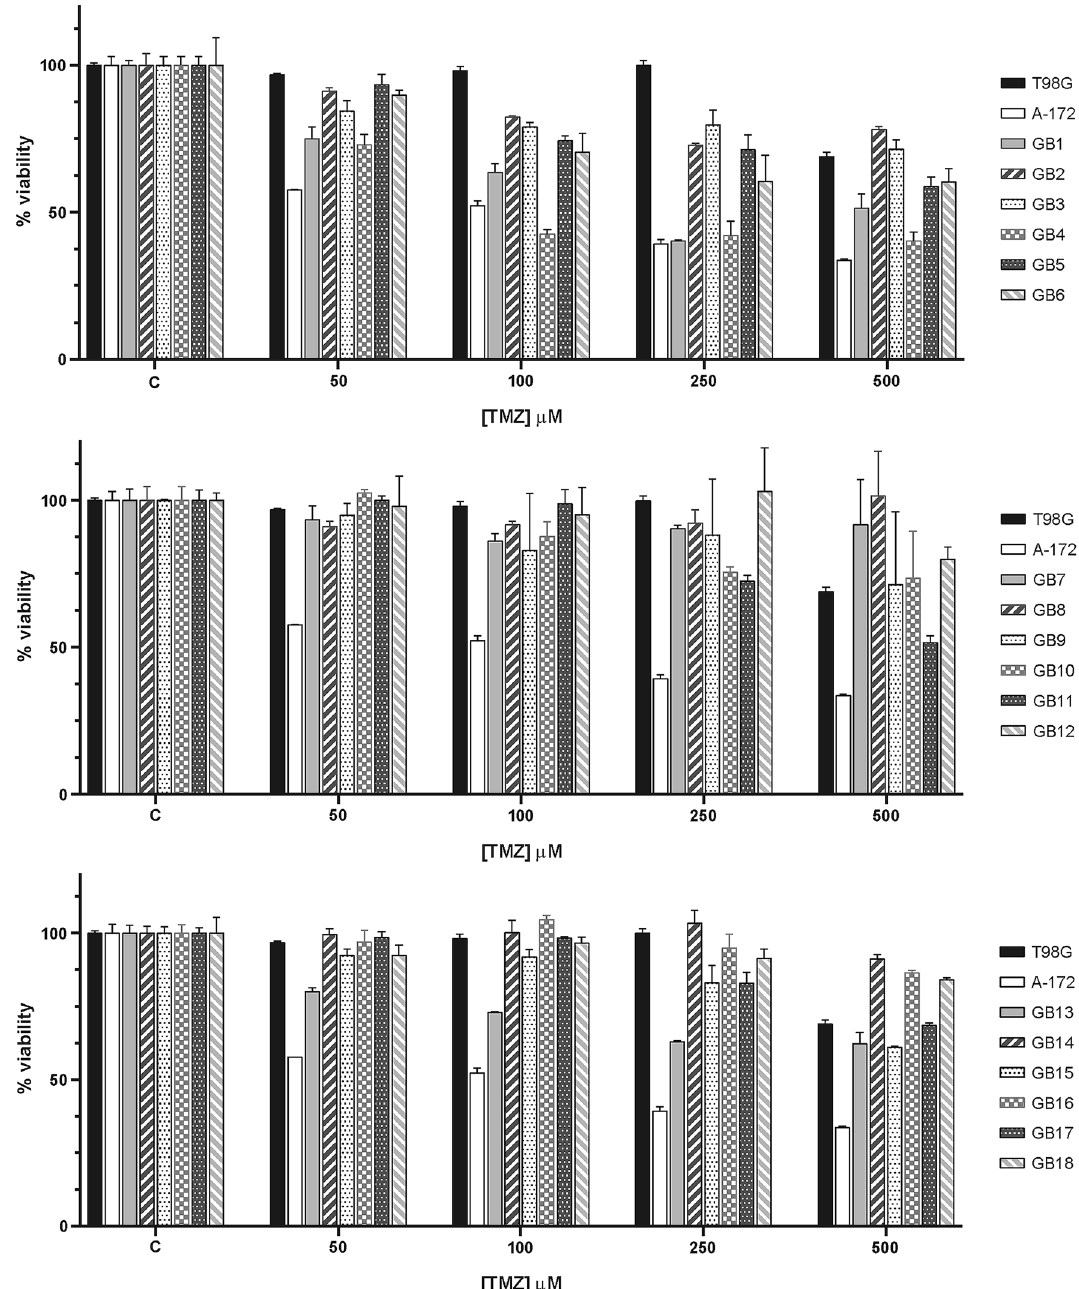
Figure 3. TMZ-induced antitumor effects on human glioma cell lines (T98G and A-172) and primary glioma cells. Cells were treated with either dimethylsulphoxide vehicle (C) or increasing concentrations of TMZ (50–500 μM) for 5 days and, then, cell viability was assessed by the MTT assay. Under exposure with the highest TMZ concentration, T98G showed a high resistance to TMZ, keeping 70% cells alive, while only 30% A-172 cells survived. Cell viability of all primary cultures remained over 40–50%. Data are presented as mean ± SD from three independent